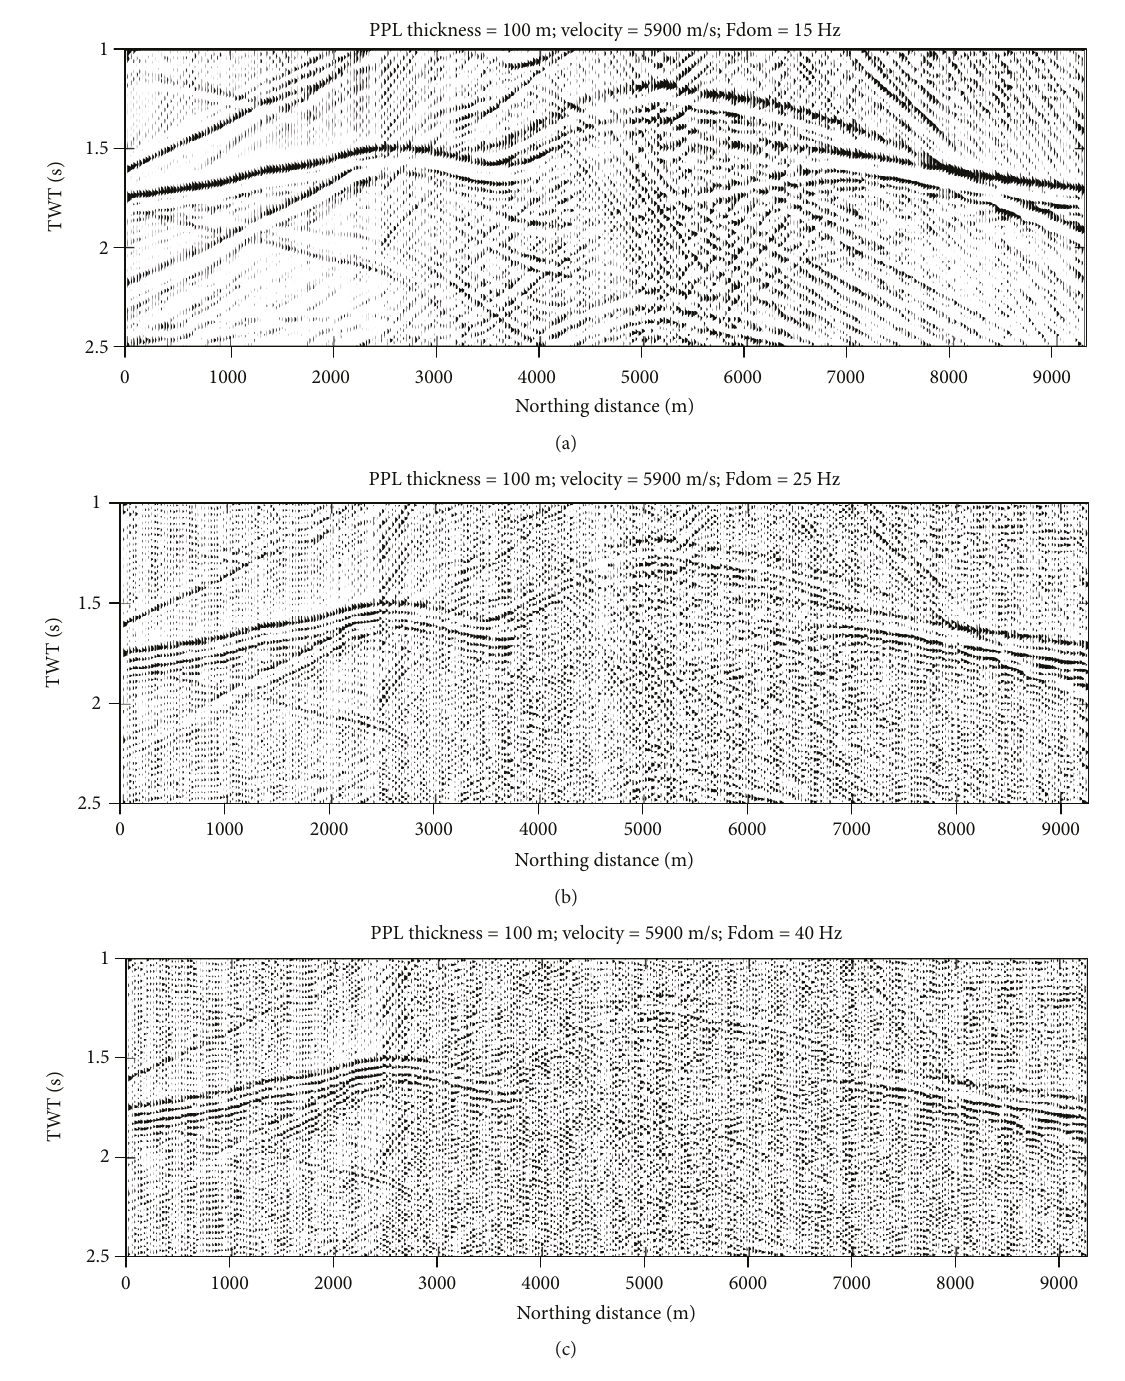
Figure 14: K-horizon synthetic response (100m PPL model) for three di ff erent central frequencies of the source wavelet: (a) 15Hz, (b) 25Hz, and (c)